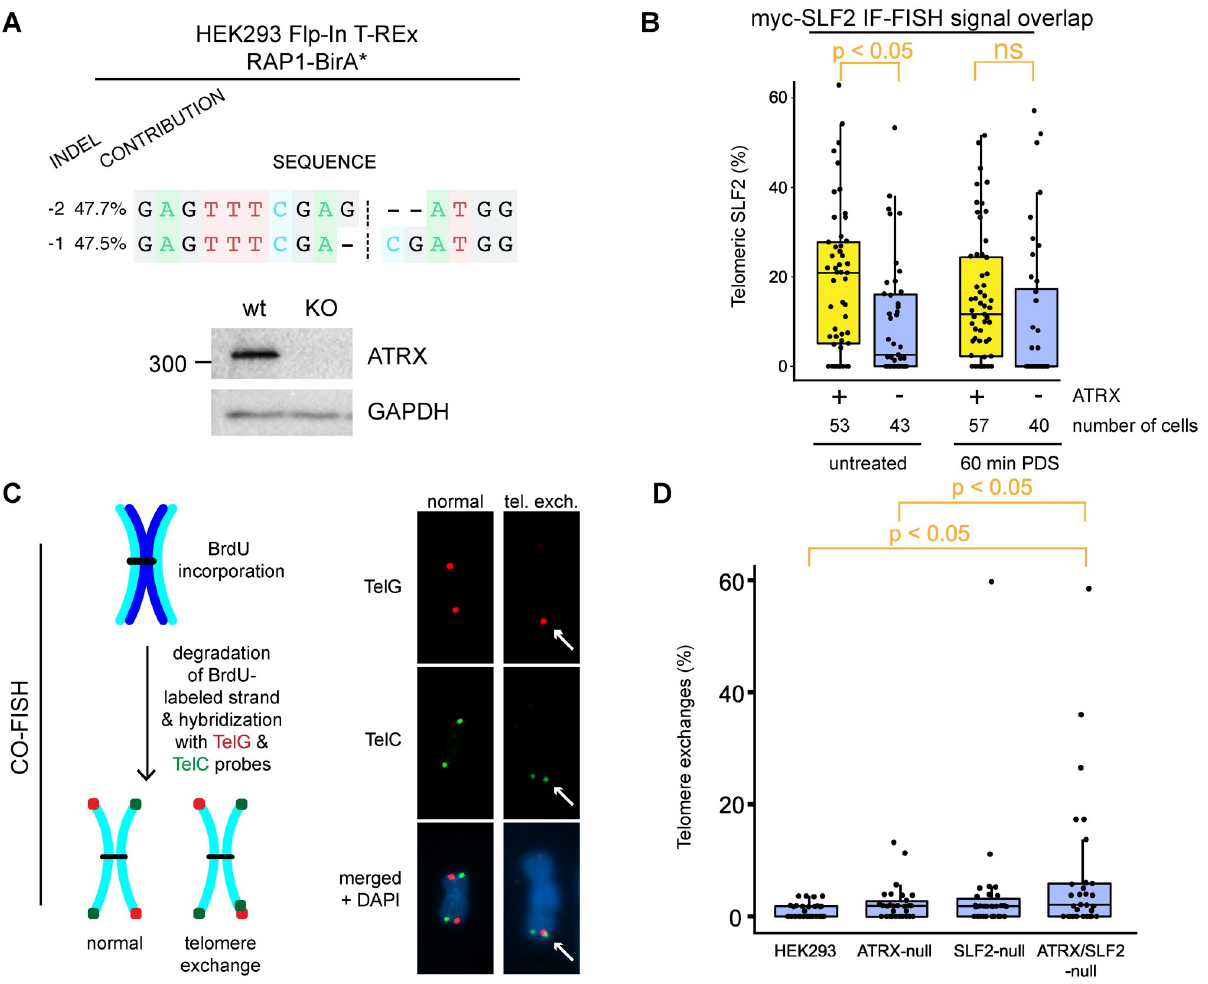
Fig 4. Loss of ATRX and SLF2 enables telomere exchanges. A: DNA sequencing and western blotting confirming the disruption of ATRX expression in CRISPR-Cas9-edited HEK293 Flp-In T-REx cells inducibly expressing RAP1-BirA � . B: Relative signal overlap between immunolabeled SLF2 and telomere fluorescence in situ hybridization (IF-FISH), in ATRX-expressing or -null HEK293 Flp-In cells. Cells were exposed to 10 μ M pyridostatin (PDS, G4 stabilizer) for 60 min. At least 40 cells per condition were analyzed using a CellProfiler colocalization pipeline [106]. ATRX loss decreased SLF2 recruitment to telomeres in the absence of pyridostatin. C: Schematic of dual-colour chromosome-orientation fluorescence in situ hybridization (CO-FISH) [64] using PNA probes to label C- and G-rich telomere strands (left). Examples of normal CO-FISH signals and of a chromosome end with a telomere exchange are shown (right). D: Relative amount of telomere exchanges in ATRX, SLF2, and ATRX/SLF2 KO HEK293 Flp-In cells. At least 30 mitotic spreads per condition were counted and the percent of telomeric exchanges plotted. p-values were obtained using a 2-sided Student’s t-test with unequal